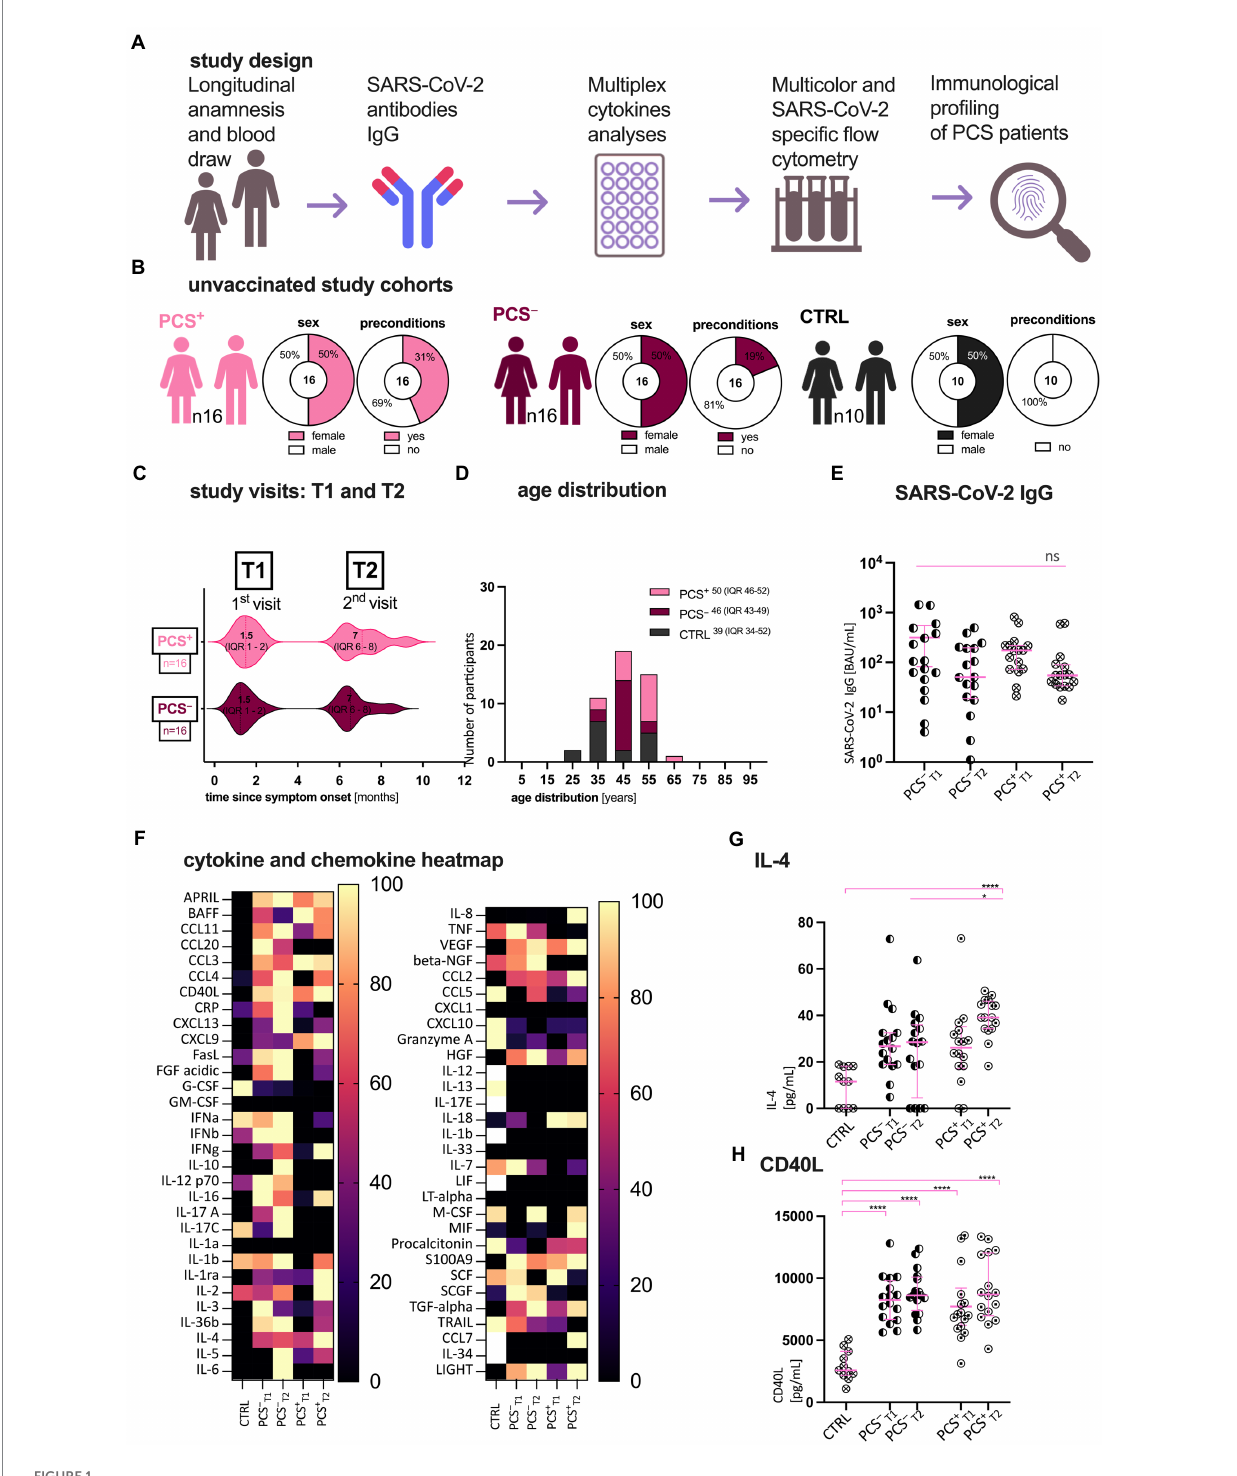
FIGURE 1 Patient characteristics, study design, and first serological assessment. (A) Study design; (B) Clinical characteristics of patients with (PCS + ) and without (PCS − ) post-COVID syndrome (PCS) and healthy volunteers (CTRL); (C) Study visits in months after symptom onset. (D) Age distribution of the cohorts. Data are expressed as absolute, percentage, or median (IQR), respectively. (E) Distribution of SARS-CoV-2 immunoglobulin G (IgG; BAU/mL); (F) Multiplex Luminex cytokine in CTRL, PCS − , and PCS + at T1 and T2, respectively. Heatmap of normalized, median cytokine ratios [%]. (G,H) Exemplary plots of cytokine distribution (pg/mL): (G) IL-4, (H) CD40L. PCS, post-COVID syndrome; PCS + , patients with PCS; PCS − , patients without PCS; CTRL, control; n , number; pg., picogram; mL, milliliter; and IQR, interquartile range. Data information: For statistical analysis, normality was assessed